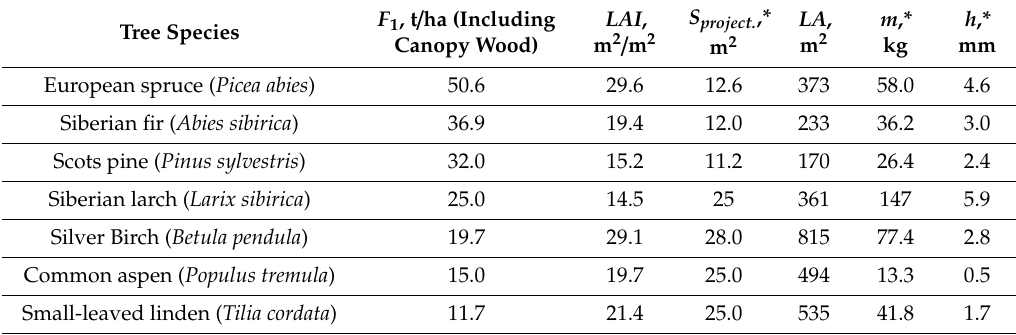
Table 3. Estimated mass of maximum possible rainfall retention by the canopies of forest-forming species (deciduous, quality class II, species age—40 years and larch, quality class II, species age—80 years, percent of canopy cover